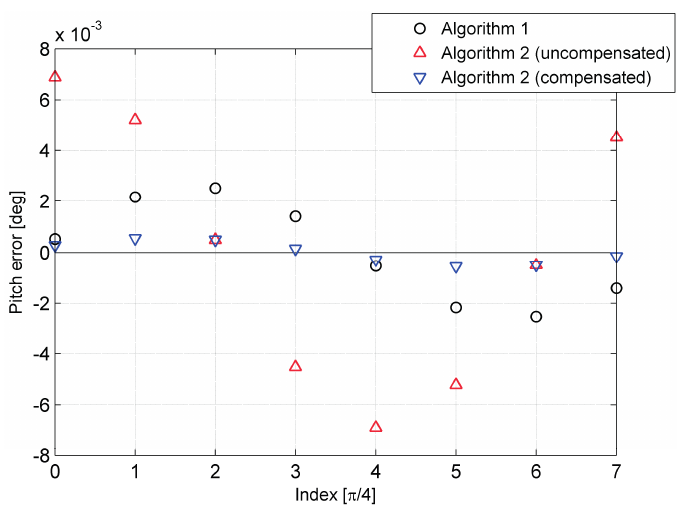
Figure 6. Heading error of the eight simulations.